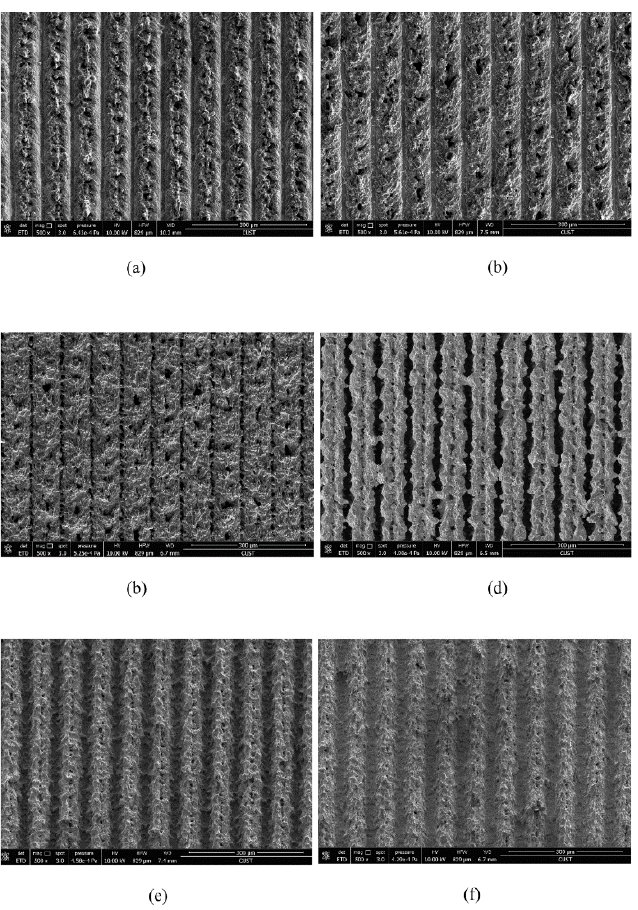
Figure 16. SEM images of surface structure under different laser scanning speeds: ( a ) 20 mm/s, ( b ) 30 mm/s, ( c ) 40 mm/s, ( d ) 50 mm/s, ( e ) 60 mm/s, and ( f ) 70 mm/s (Reprinted with permission from Ref. [64]. 2017, Yang, Z.).